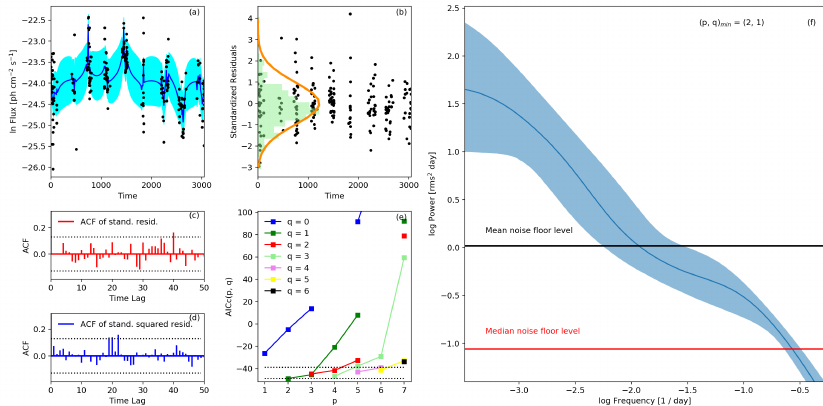
Figure 2. Results of CARMA modeling on the long-term light curve (Figure 1a). Panel ( a ) gives the logarithmically-transformed light curve along with the modeled values based on the best-fit Continuous-Time Auto-Regressive Moving Average (CARMA) process. Panel ( b ) shows the standardized residuals and their distribution compared with the expected normal distributions. Panel ( c ) gives the corresponding ACF compared with the 95% confidence regions, shown by dotted lines, for a white-noise process. Panel ( d ) gives the squared ACF compared with the 95% confidence regions, shown by dotted lines, for a white-noise process. Panel ( e ) gives the AICc values for different ( p , q ) pairs (bands within the dotted lines refer to AICc values ranging from the lowest AICc to the lowest AICc + 10, which marks all the model sets, which are statistically indistinguishable from each other). Panel ( f ) shows the resulting PSD with the 2 σ confidence region, as well as noise floor levels, P stat , marked by horizontal black (=10.4 rms 2 day, corresponding to the mean sampling interval of 13 days) and red (=0.08 rms 2 day, corresponding to the median sampling interval of two days) lines, respectively. The best-fit CARMA model is obtained for p , q = 2,1.